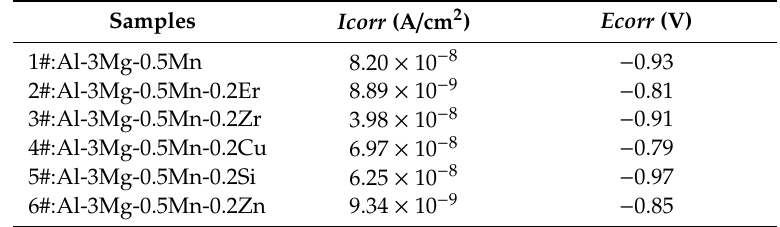
Table 4. Electrochemical parameters of cold rolled alloys in 3.5wt.% NaCl